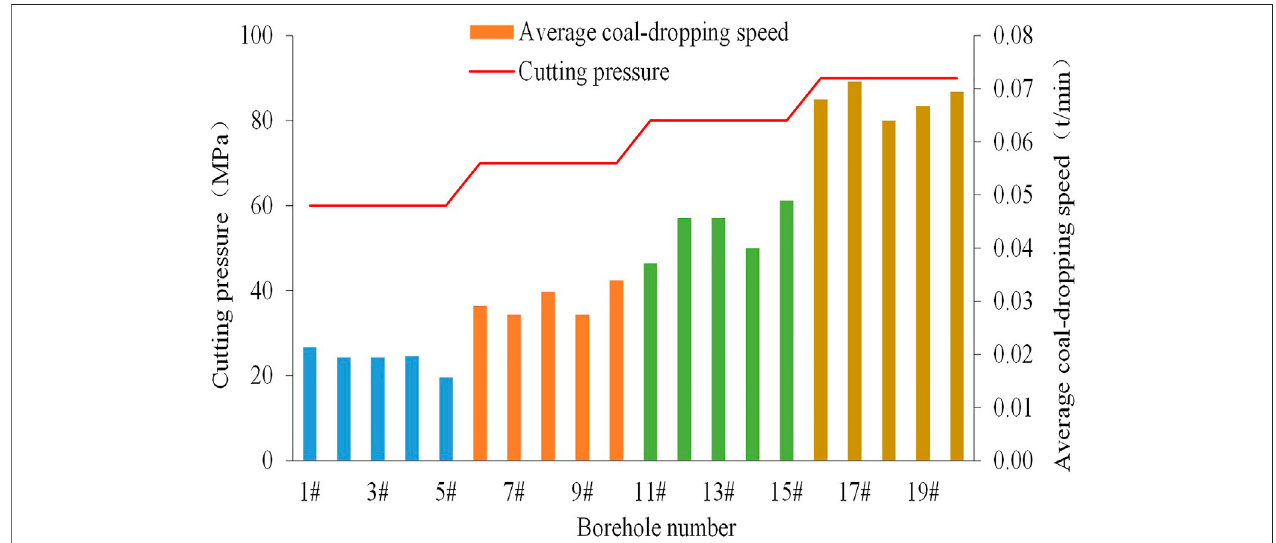
FIGURE 4 | Relationship curve between the cutting pressure and coal-dropping speed in coal seams with Protodyakonov coef fi cient in the range of 0.5 – 0.8.